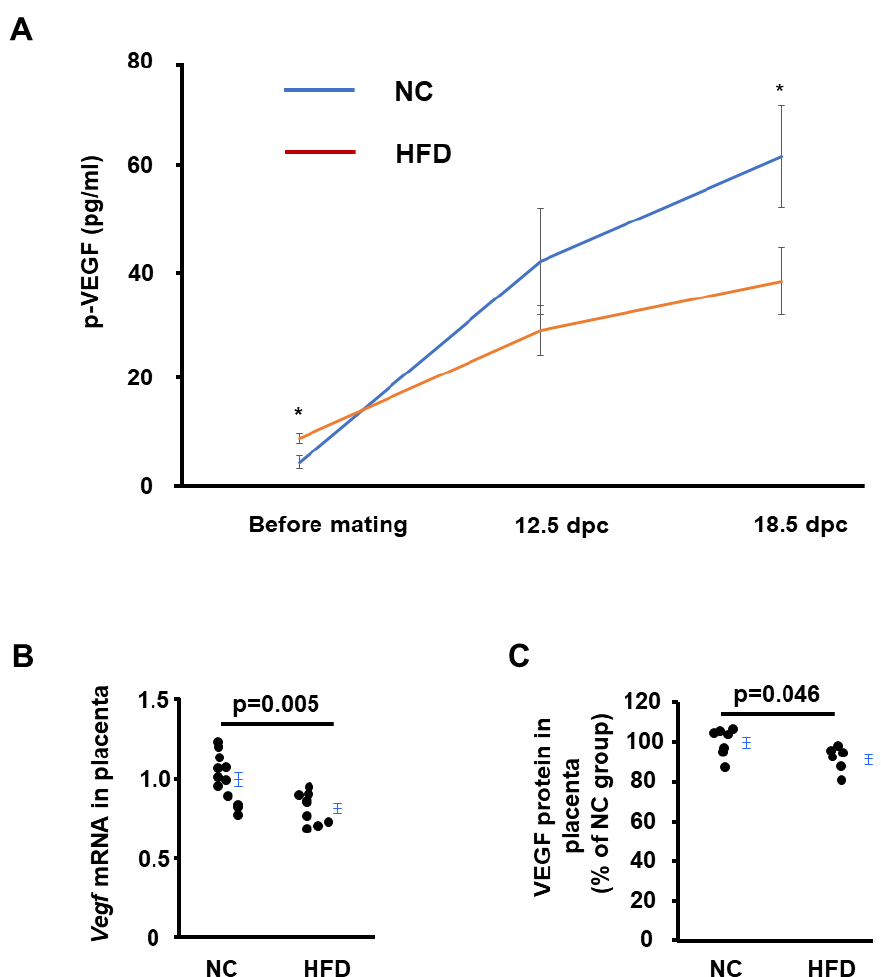
Figure 4. Asb4 −/− pregnant mice fed a high-fat diet (HFD) have decreased VEGF levels in circulation and the placenta. Placentas were collected from Asb4 −/− dams on normal chow (NC) or a high-fat diet (HFD) at 18.5 dpc. ( A ) Plasma levels of VEGF at different stages of pregnancy; p: plasma. * p < 0.05. Individual animal values at each time point are shown in Figure S4. ( B ) mRNA levels of Vegf in placentas; n = 12 (NC), 9 (HFD). ( C ) Protein levels of VEGF in placentas. NC: normal chow; HFD: high-fat diet. n = 7 (NC), 6 (HFD).